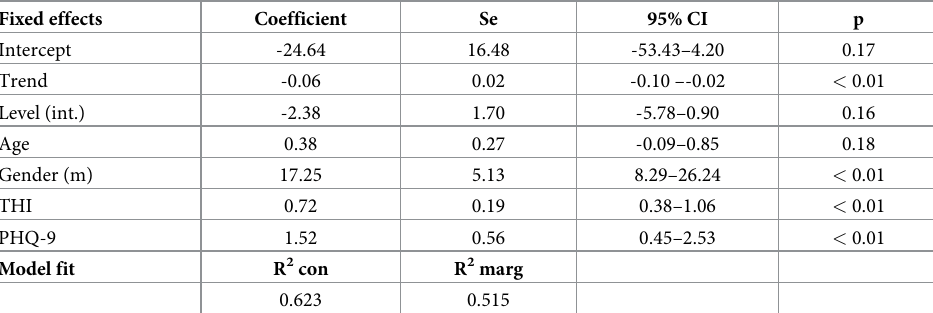
Table 5. Mixed effect model.